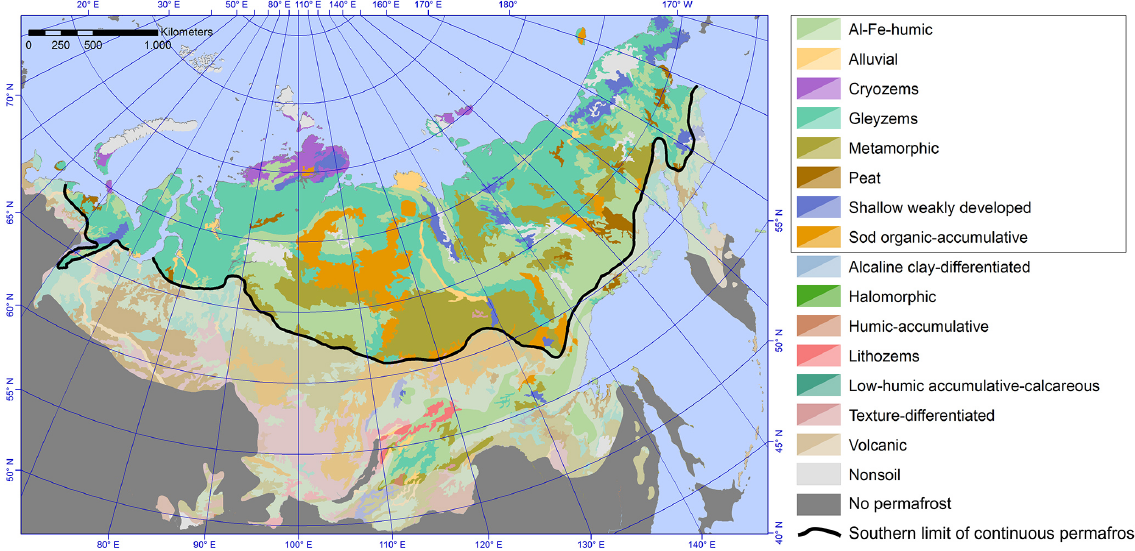
Figure 5. Distribution of soil types across permafrost-affected parts of the Russian Federation. Soils developing within the area of continuous permafrost can certainly be assumed as permafrost-affected soils (dominating soil types in the grey box). Soils in the area of discontinuous, sporadic and isolated permafrost plotted in pastel colours (south of the black limit line of continuous permafrost) are likely to be assumed as permafrost-affected soils. Based on Stolbovoi et al. (2002) and Brown et al. (1998).